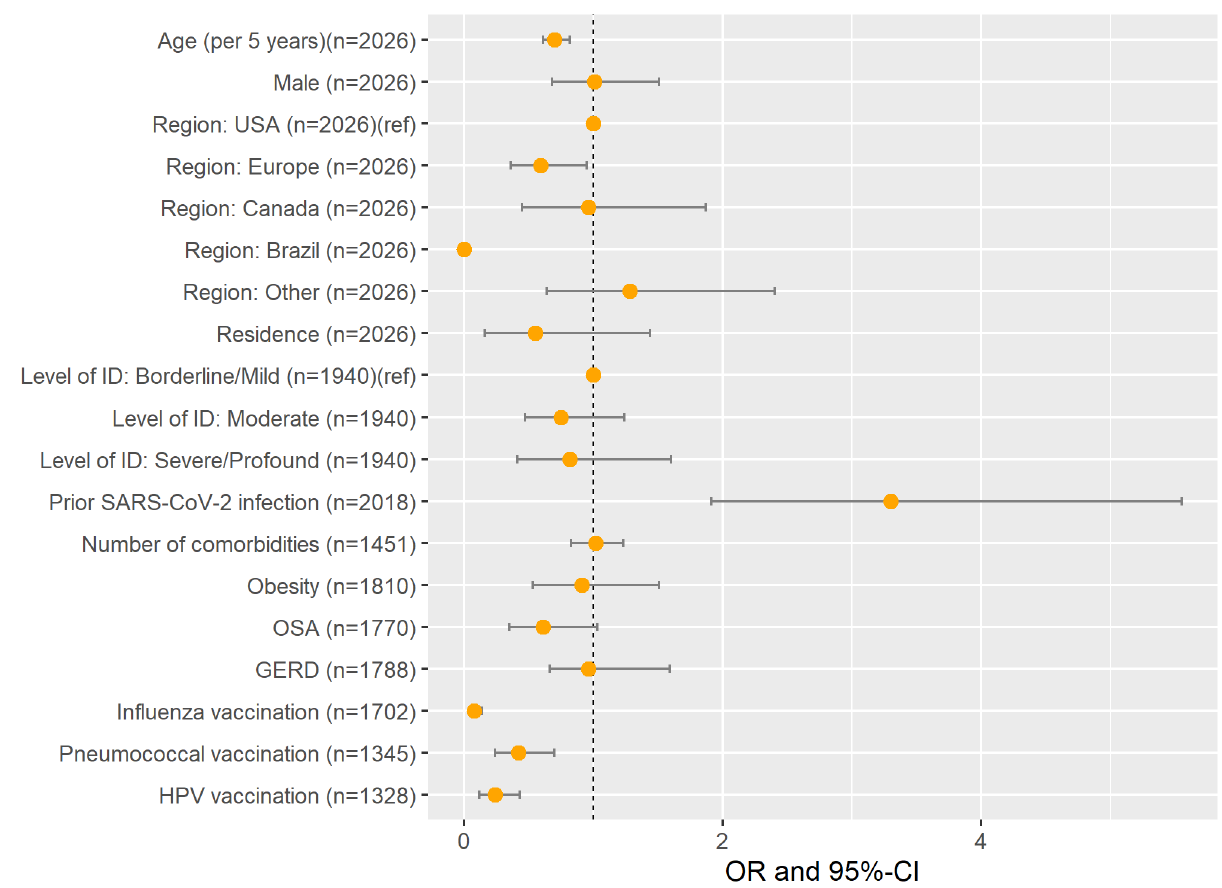
Figure 2. Factors associated with being unvaccinated by choice estimated with adjusted logistic regression models with vaccination status as dependent variable (unvaccinated by choice versus vaccinated [reference category]) (adjusted odds ratios (OR) and 95% confidence intervals (95% CI)). All associations were adjusted for age, gender, country, and residential setting unless one of these covariates was the independent variable of interest. Brazil had zero responses of being unvaccinated by choice. See Table 1 for details on how many participants were included from each European country. Other: Australia (n = 25), Colombia (n = 4), India (n = 104), Mexico (n = 6), Saudi Arabia (n = 5), and other countries with fewer than 4 participants. Residence: Living at home with family (reference group) versus other living conditions (see Table 1 for details on the other categories). For gender, the reference category was “female” (participants who identified neither as male nor female were excluded because of the low case number). For prior SARS-CoV-2 infection, comorbidities, and other vaccines, the references categories did not have those infection/comorbidities/vaccines. For factors with more than two categories, reference categories are included in the figure (ref). Comorbidities included in “number of comorbidities”: obesity, Alzheimer’s disease, thyroid